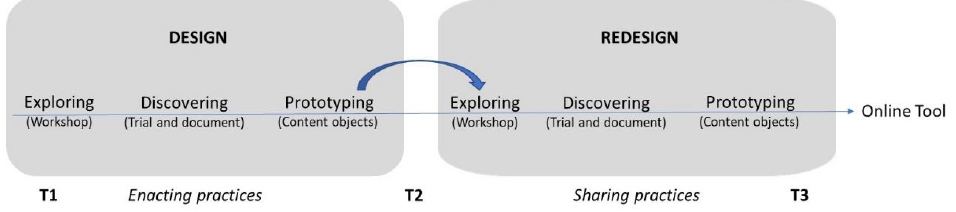
Figure 1. Phases of the design and redesign cycles.